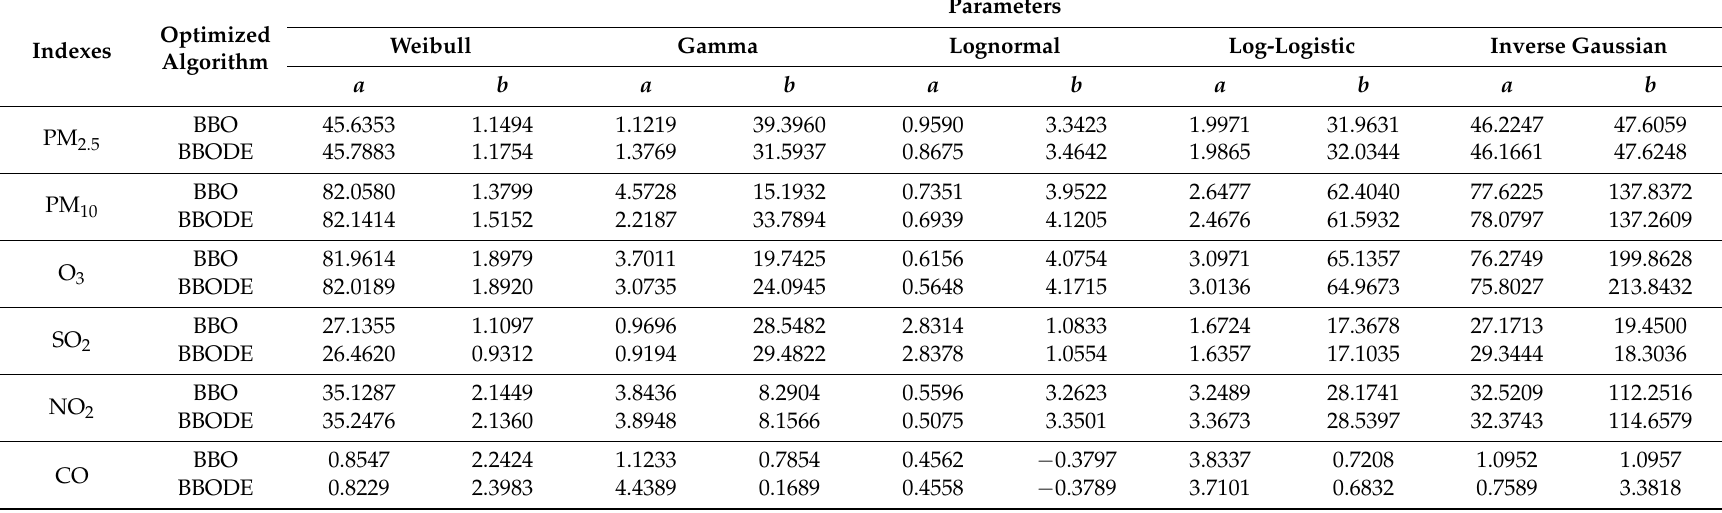
Table 5. Parameters of the different distributions based on the different optimized algorithm. In Table 5, a and b represent scale and shape parameters of distribution functions,